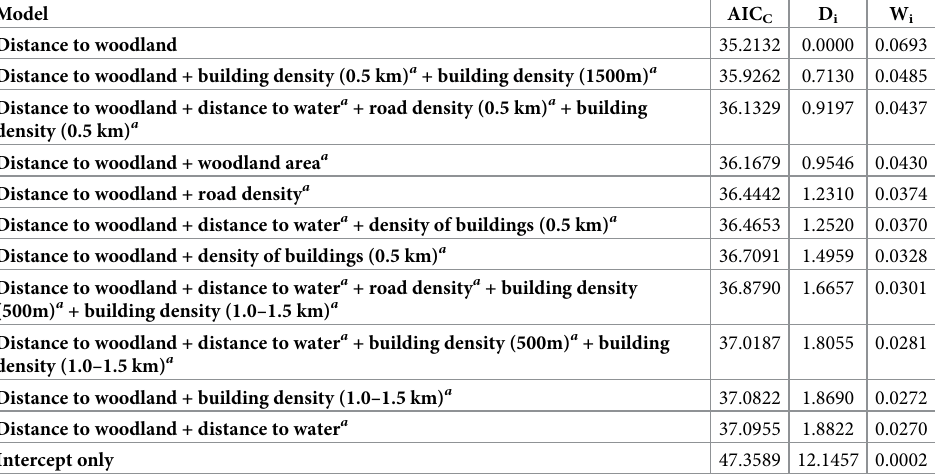
Table 3. Top models ( Δ i < 2) assessing the impact of landscape features on building occupancy by T . mauritianus based on AIC C and Akaike weight W i . Results based on comparisons made between roosts and random controls.